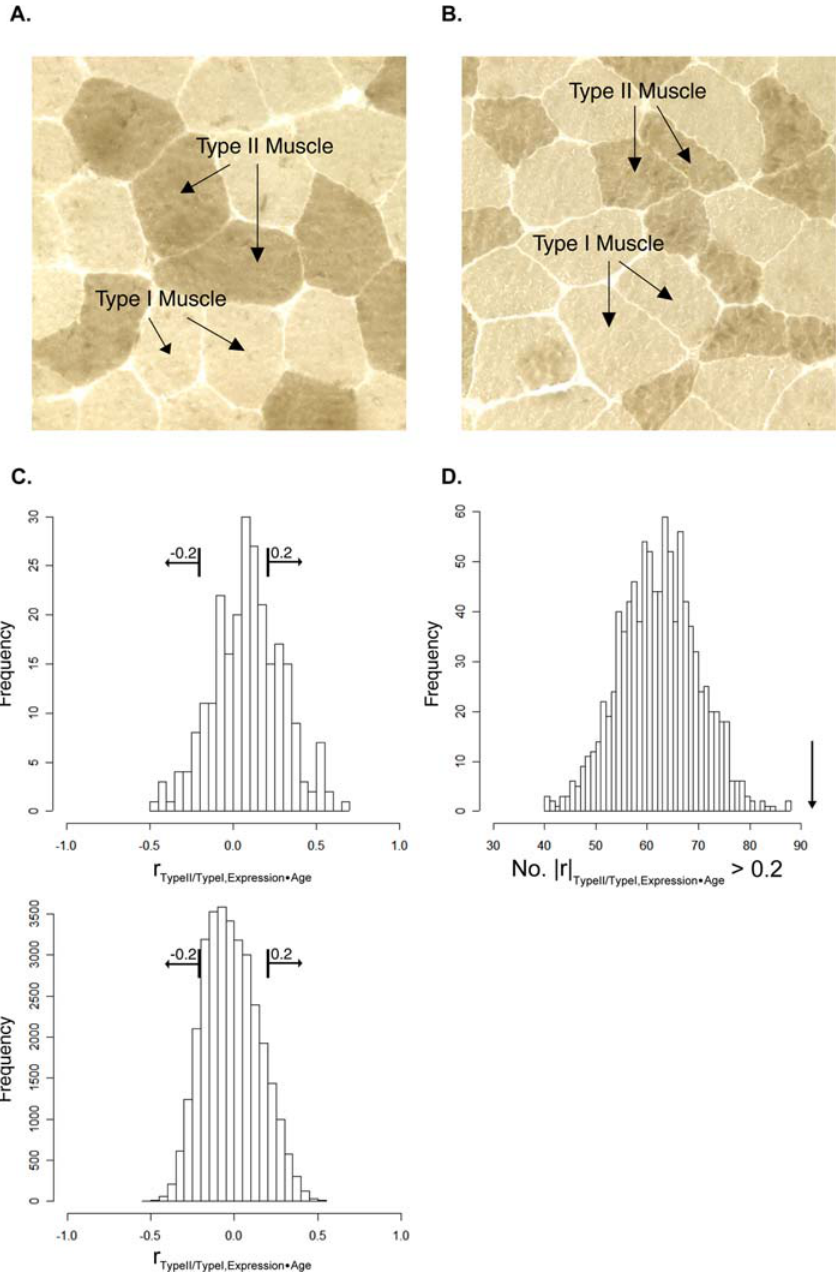
Figure 3. Gene Expression Predicts Physiology of Aging (A) Cross-section of histologically unremarkable deltoid muscle from a 48-y-old woman demonstrating relatively equivalent sizes of types I and II muscle fibers. Arrows denote fibers types as distinguished by enzyme histochemistry (cryosection, 200 3 , myosin ATPase at pH 9.4). (B) Cross-section of deltoid muscle from an 88-y-old woman demonstrating selective atrophy of type II muscle fibers that stain darkly by ATPase enzyme histochemistry (cryosection, 200 3 , myosin ATPase at pH 9.4). (C) Histograms showing a correlation between muscle physiology and gene expression for age-regulated genes. Top panel: for each of the 250 age- regulated genes, we calculated the partial correlation coefficients between the type II/type I muscle fiber diameter ratio and gene expression excluding age variation ( x -axis). Bottom panel: same as top panel, except that correlation coefficients were calculated for all 31,948 genes. The squared partial correlation coefficient denotes the amount that changes in gene expression account for variance in type II/type I muscle fiber diameter ratios while excluding the effects of age. (D) Histogram showing the likelihood of finding 92 genes with j r j . 0.2 from a set of random genes. We performed a Monte Carlo experiment by randomly selecting sets of 250 genes from the genome, and calculating how many genes in the set had j r j . 0.2 as in (C). The procedure was repeated 1,000 times and the histogram shows the number of genes from each random selection that have j r j . 0.2. The arrow shows the number of genes exceeding this threshold (92) from the set of 250 age-regulated genes ( p , 0.001). We also determined the total number of genes in the genome with j r j . 0.2, and then showed that 92 genes from a set of 250 is significant (hypergeometric distribution; p , 1 3 10 (cid:1) 4 ). DOI: 10.1371/journal.pgen.0020115.g003